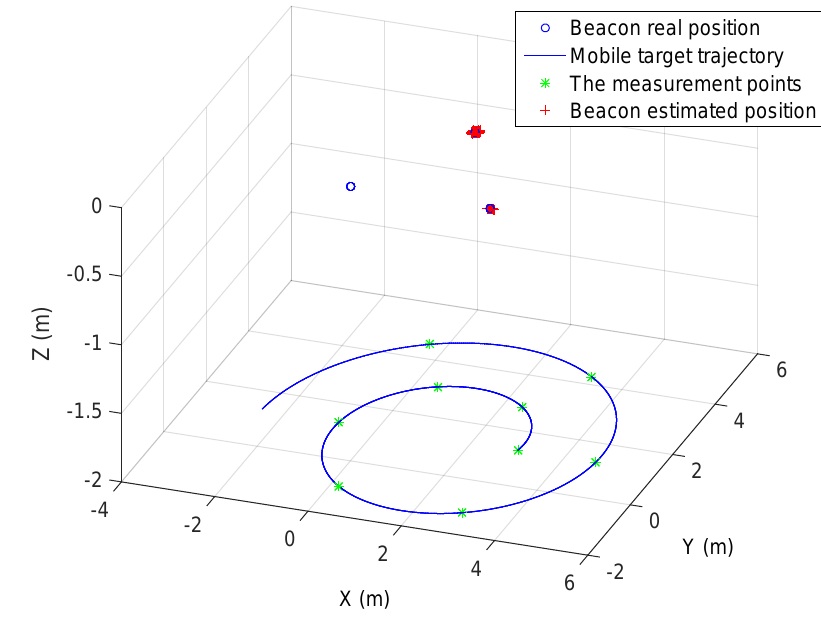
Figure 7. The simulation